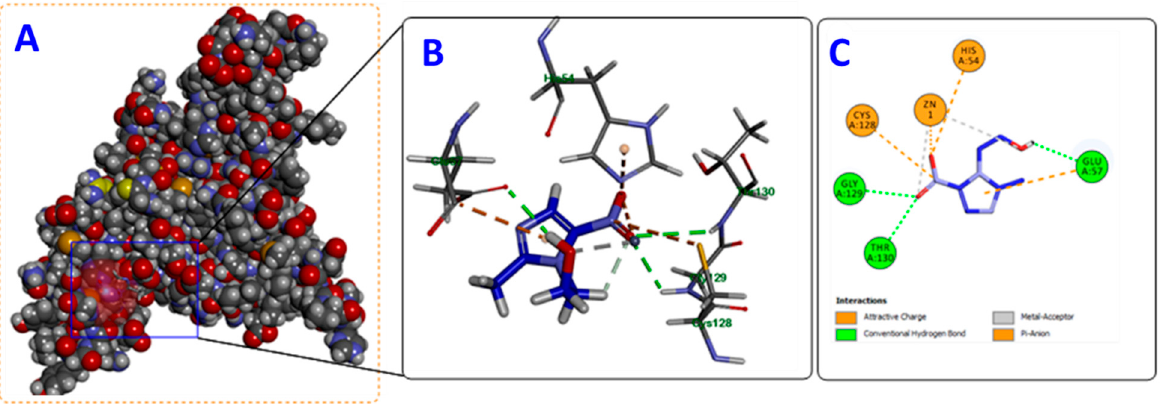
Figure 6. Interactions of metronidazole into the active site of P. mirabilis QS protein (PMI1345). ( A , B ) three dimensional and ( C ) two dimensional.